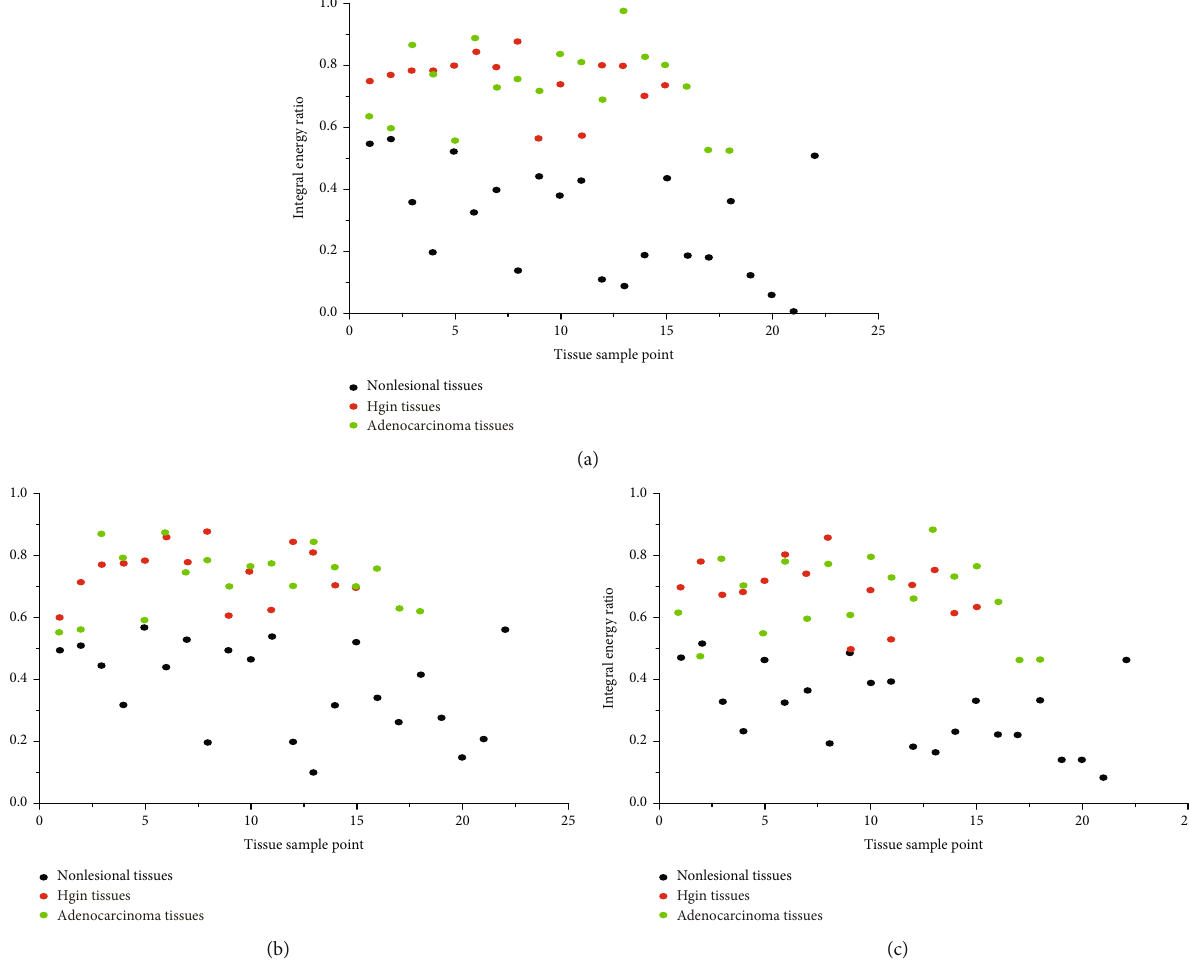
Figure 8: Scatter diagrams of (a) the integral energy ratio in the noncontinuous frequency band, (b) the integral energy ratio in the continuous frequency band, and (c) the peak intensity